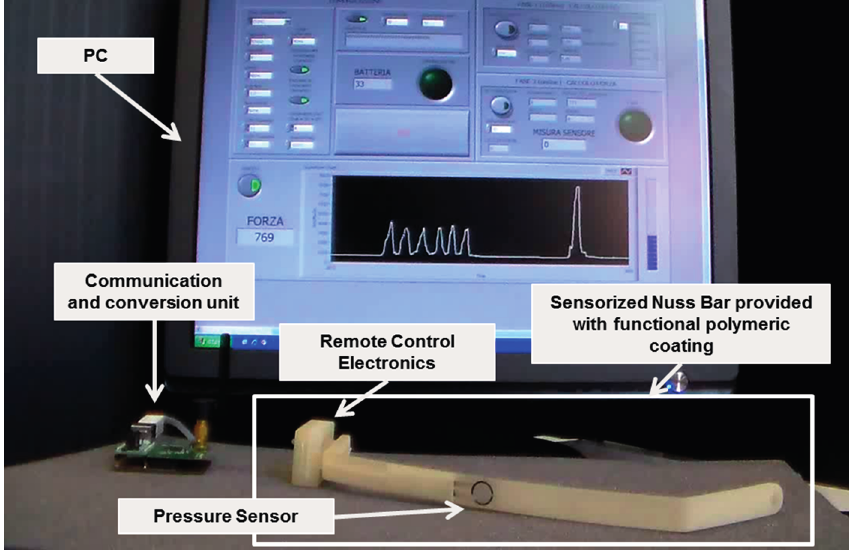
Figure 2. Prototype of the system: A prototype of the sensorized Nuss bar was developed in a plastic resin by using a 3D printer (3DSYSTEM PROJET HD 3000), provided with key components, enabling the management and transmission of pressure data. Both the sensorized Nuss bar structure and the sensor were covered by a micrometric polymeric coating.